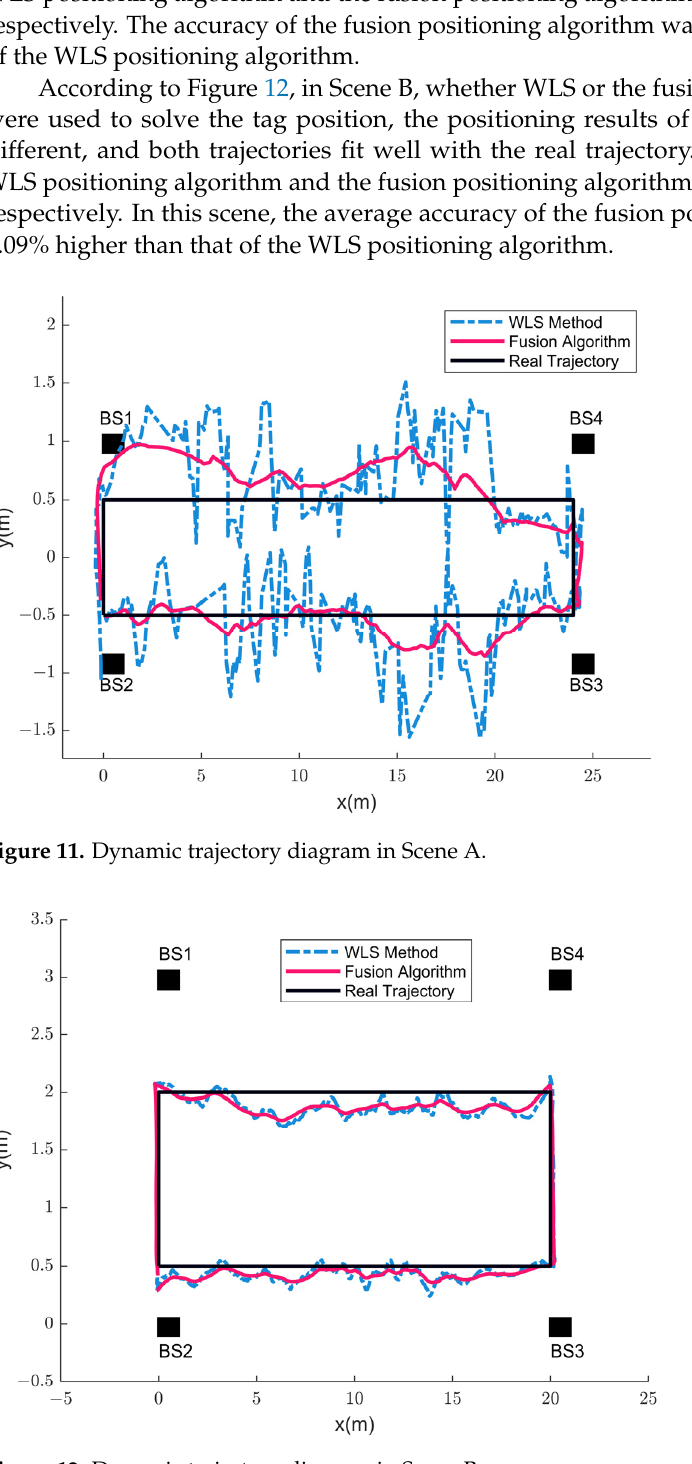
Figure 12. Dynamic trajectory diagram in Scene B.